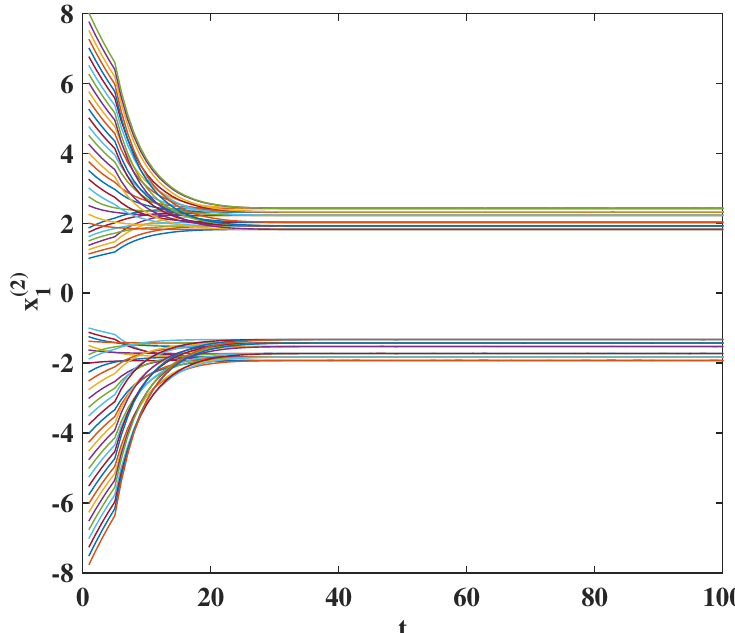
( 2 ) for system (22). 1